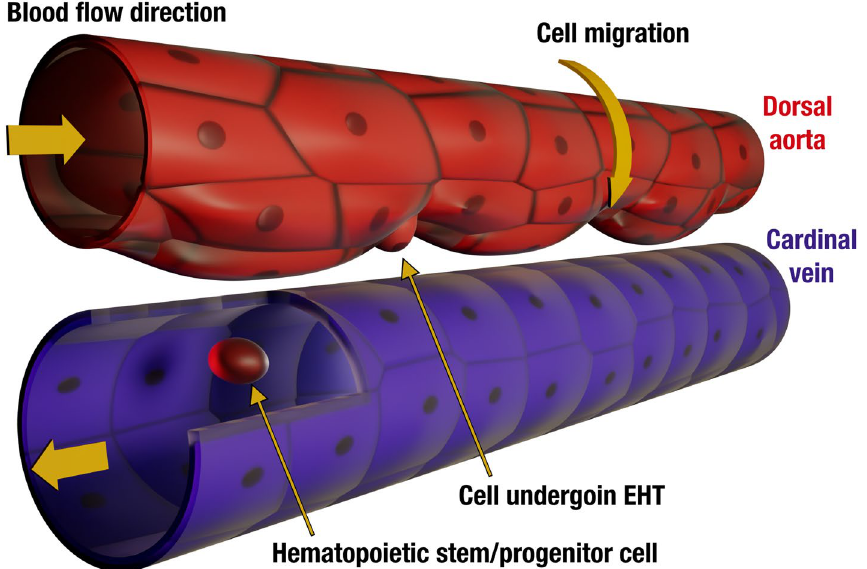
Figure 1. Illustration of zebrafish embryonic dorsal aorta and cardinal vein at 50 hpf. HSPC production is accompanied by a collective cell migration toward the ventral part of the DA and an emergence of the periodic pattern of alternating thinner and thicker regions with a well-defined wave vector. Cells that undergo endothelial-to-hematopoietic transition leave the aorta and enter the cardinal vein becoming HSPCs (shown through a longitudinal section in the cardinal vein). Horizontal yellow arrows show blood flow